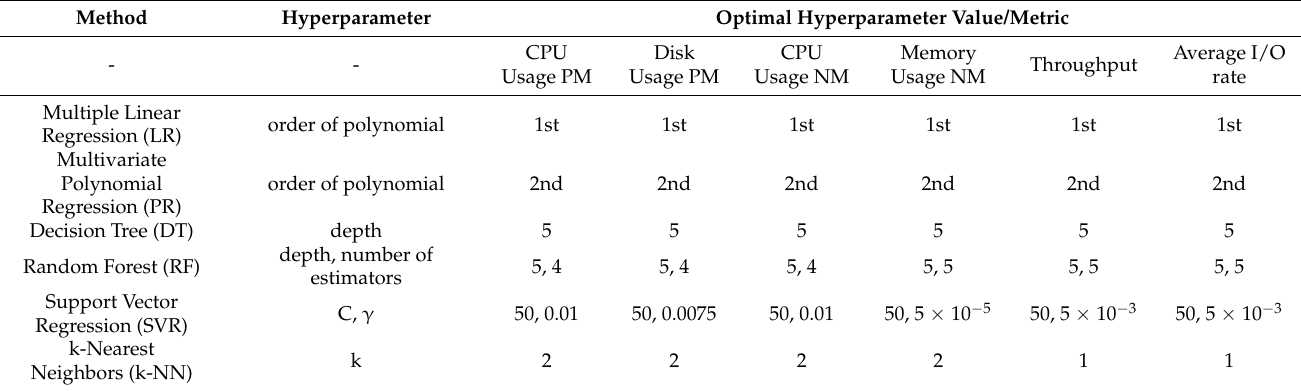
Table 4. Optimal hyperparameters for each ML algorithm and metric.